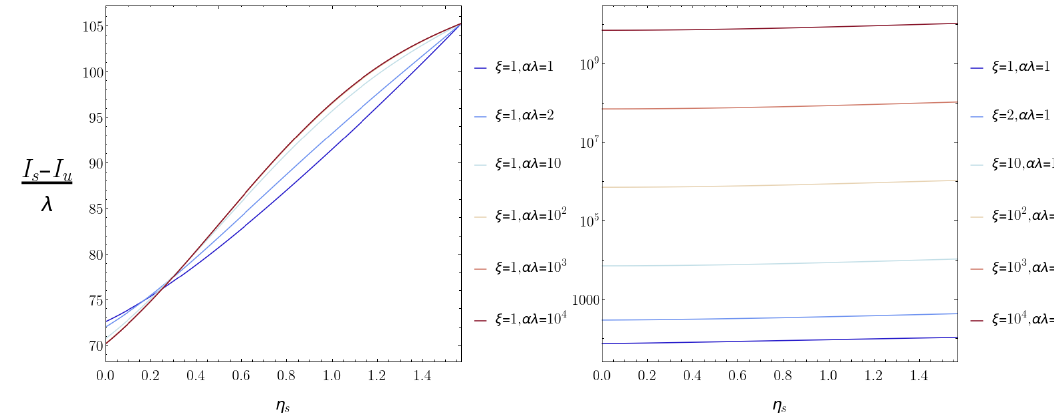
Figure 4 . Difference of the Euclidean actions for black holes with the same temperature at the black hole horizon, varying separately αλ , in the first panel, and ξ in the second